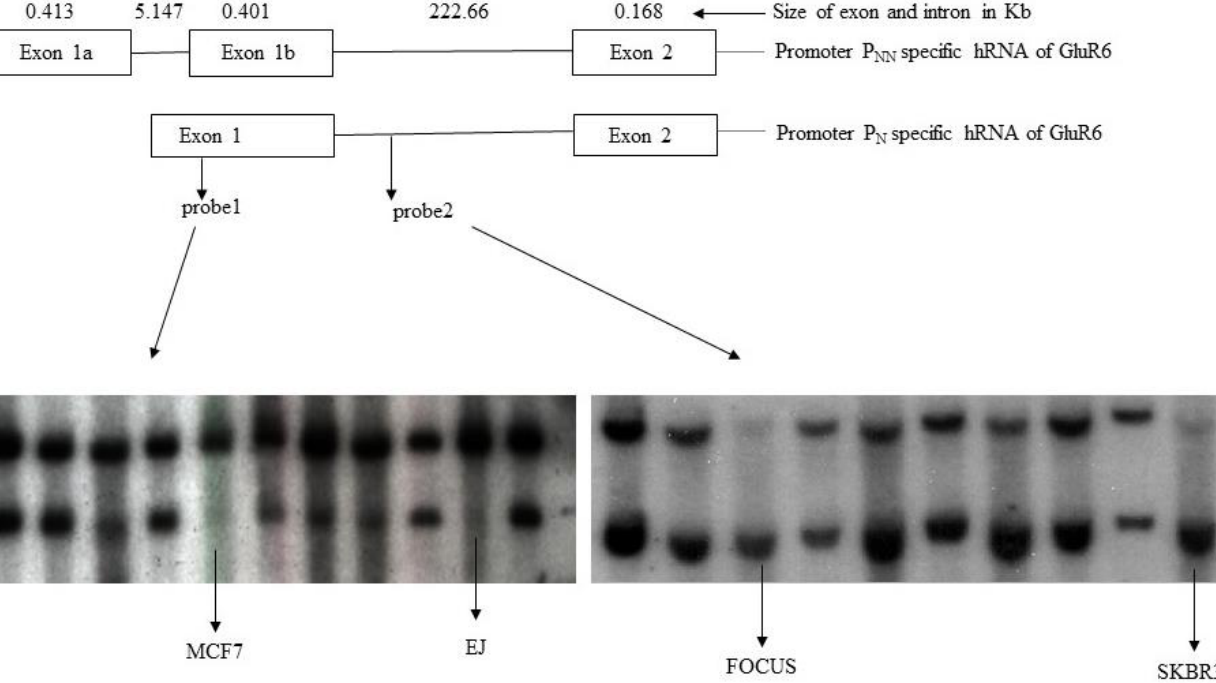
Figure 2. Southern hybridization of restriction enzyme digested DNA from tumor cell lines. Top two rows show the location of introns and exons transcribed by non-neuronal and neuronal promoters. The probes (probe 1 and probe 2) used for hybridization are indicated in the second row. The lanes showing rearrangements at GluR6 locus in MCF7, FOCUS, EJ, and SKBR3 cells are marked.